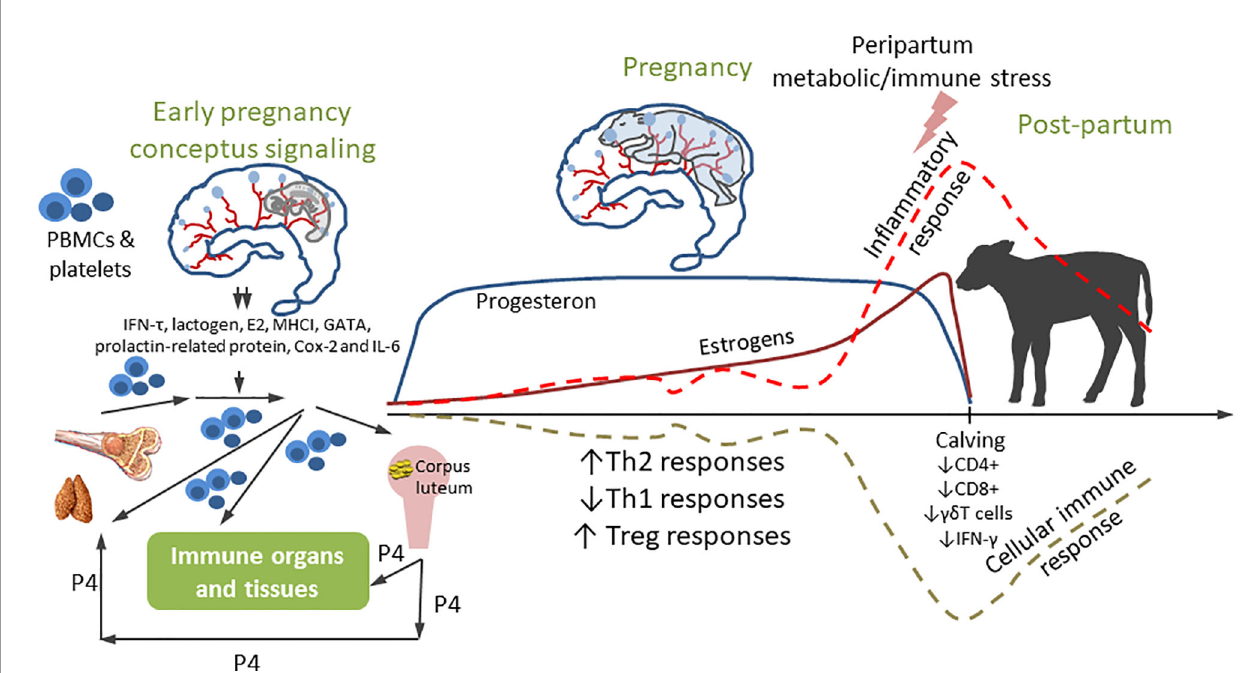
FIGURE 1 | Immune modulation during pregnancy. Early conceptus signaling modulates local and systemic immunity. The peripheral blood mononuclear cells (PBMC), platelets and cell-free DNA from bone marrow/thymus modulated by high level of P4 from corpus luteum enter blood circulation. Then, the PBMC, platelets and cell-free DNA while migrating through blood circulation to endometria, are controlled by IFNT and other conceptus immune factors. Then the functionally changed PBMC, platelets and cell-free DNA re-enter blood/lymph circulation and traf fi c to effector cells affecting the function of the immune organs and non-immune organs including ovary. This early signaling shifts immune environment to Th2 to maintain the pregnancy. In fl ammatory responses sharply increase, and cellular immune function is down-regulated around